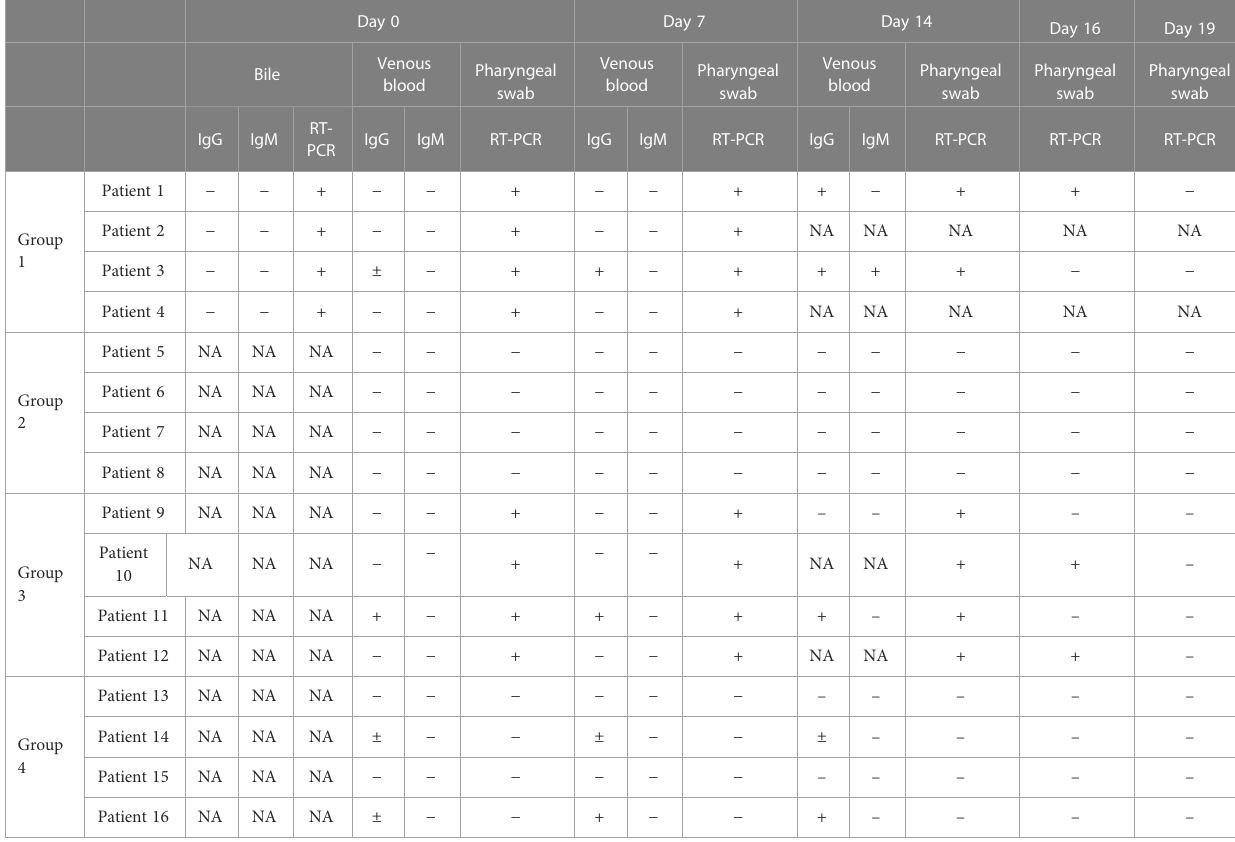
TABLE 3 RT-PCR and IgG and IgM detection of four